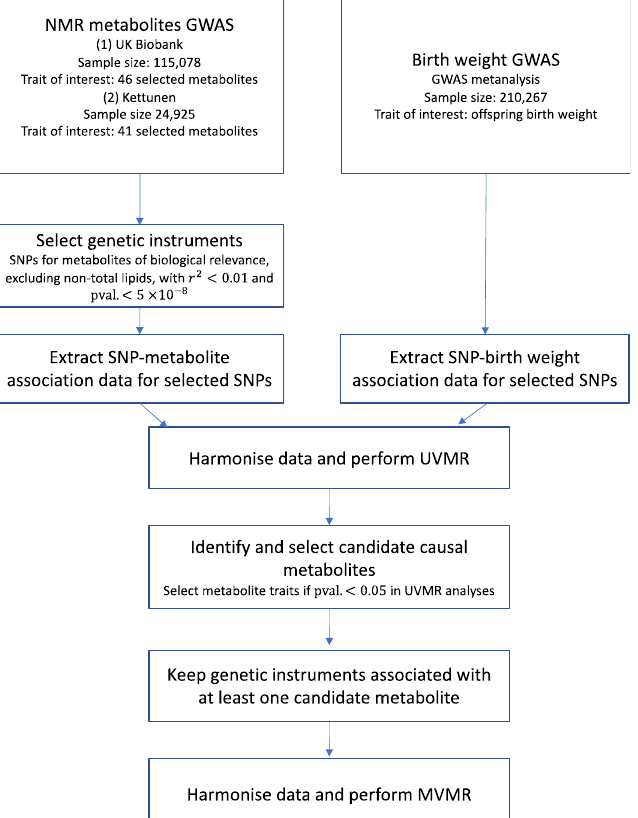
Figure 3. A summary of methods used to select and estimate effects of metabolic traits on offspring birthweight in the Mendelian randomisation analysis. GWAS: genome-wide association study, MVMR: multivariable Mendelian randomisation, NMR: nuclear magnetic resonance, SNP: single- nucleotide polymorphism, UKBB: UK Biobank, UVMR: univariable Mendelian randomisation, r 2 : genetic correlation between SNPs.